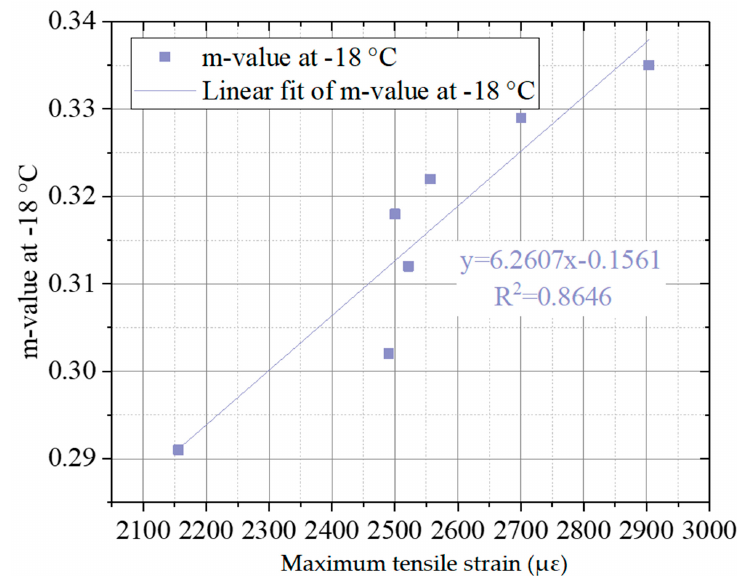
Figure 11. The linear fit of maximum tensile strain and